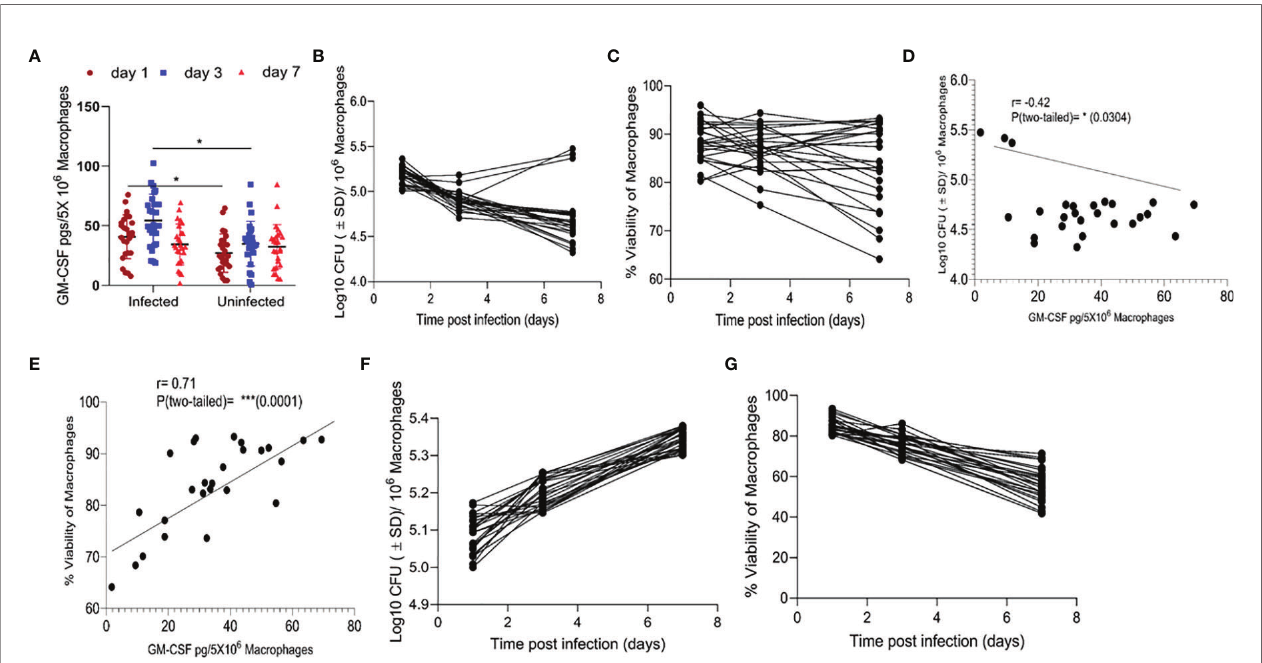
FIGURE 1 | Association between GM-CSF secretion levels, bacterial burden, and cell viability of macrophages post- M. tuberculosis infection. (A) Secreted levels of GM-CSF by M. tuberculosis in infected and uninfected macrophages of different individuals after differentiation.pg = picogram. (B) M. tuberculosis burden in macrophages of different individuals after differentiation as measured by CFU assay over seven days of infection. (C) Cell viability of M. tuberculosis -infected macrophages after differentiation measured by alamarBlue assay over seven days of infection. (D) Two-tailed correlation analysis between secreted GM-CSF levels and M. tuberculosis burden in macrophages on day 7 post-infection. (E) Two-tailed correlation analysis between secreted GM-CSF levels and cell viability of macrophages on day 7 post-infection. (F) M. tuberculosis burden in undifferentiated macrophages by CFU assay over 7 days of infection. (G) Cell viability of M. tuberculosis -infected undifferentiated macrophages by alamarBlue assay over seven days of infection. Data represent average of three independent experiments carried out in duplicate. Bars and error bars represent mean and SD, respectively. *p ≤ 0.05, ***p ≤